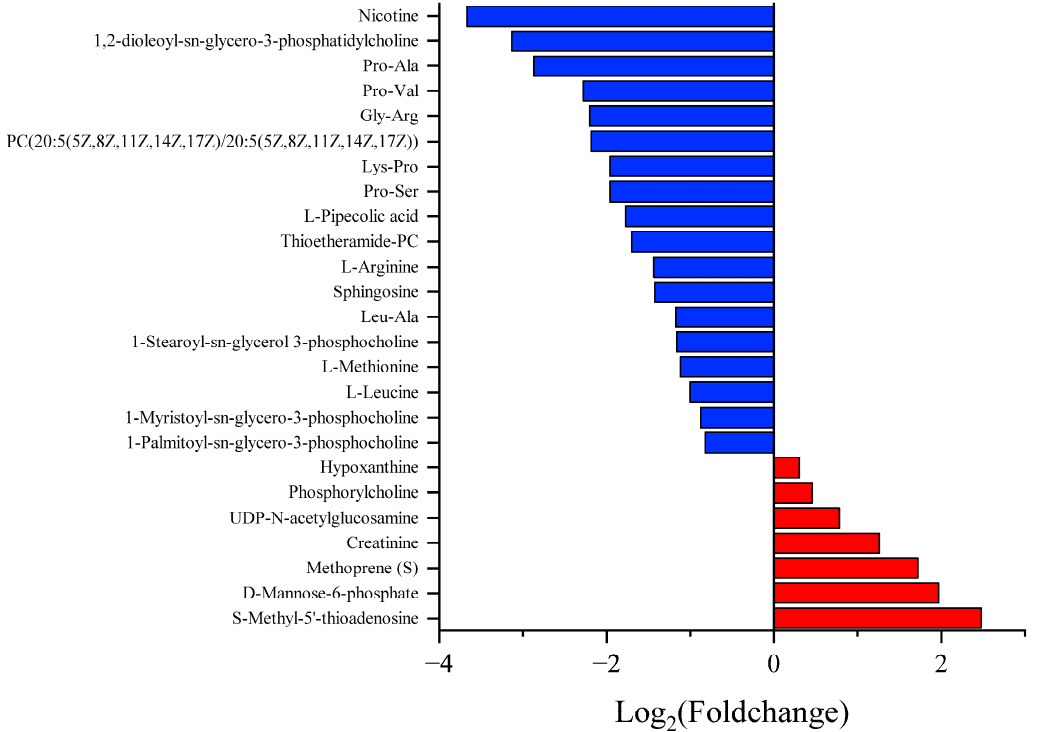
Figure 2. Differentially accumulated metabolites in the liver between two groups in the negative polarity mode (BR vs. BS).